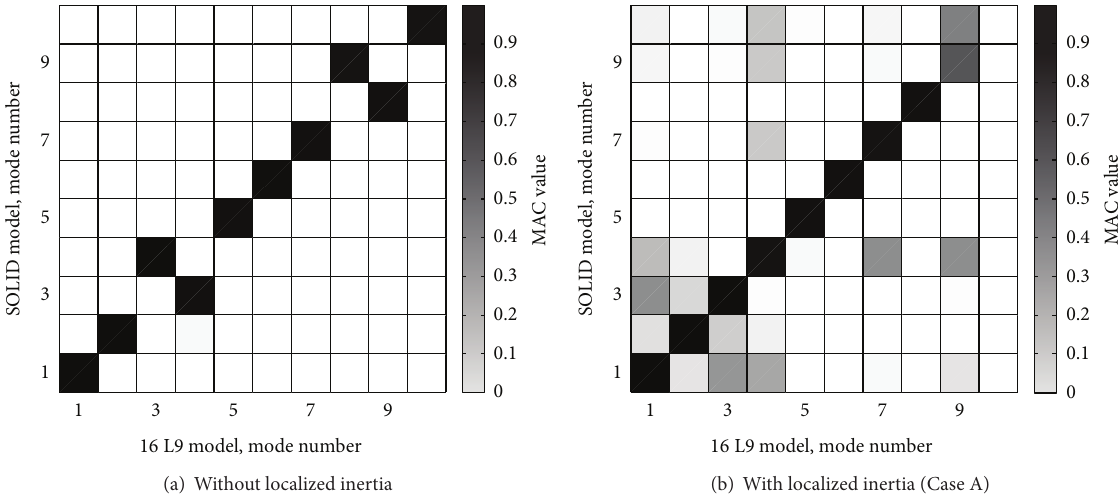
Figure 21: MAC values between the 16 L9 and FEM-3D models of the hollow-rectangular box